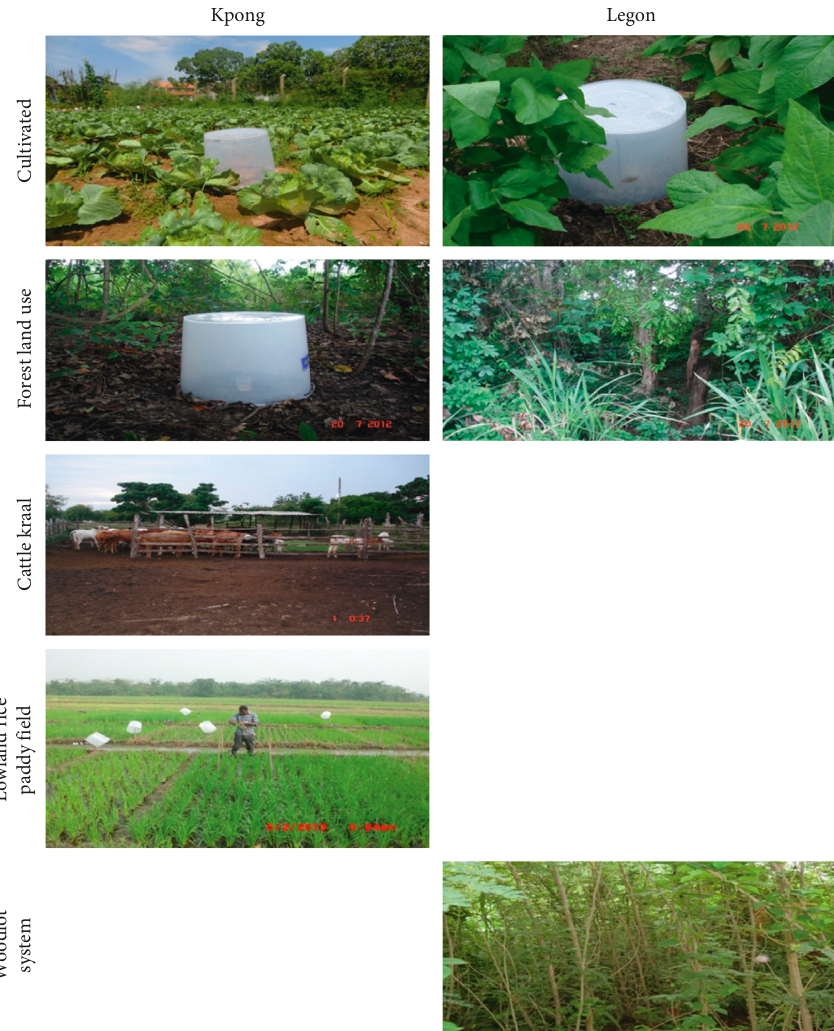
Figure 2: Layout of identified land-use systems used for the